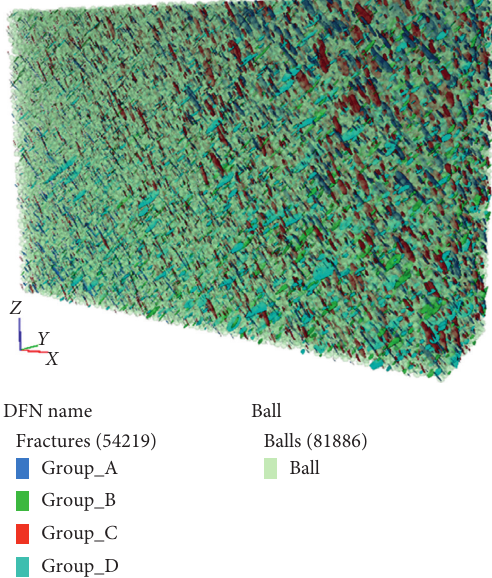
Figure 17: Jointed rock slope model before excavation of Shuichang open-pit iron mine.